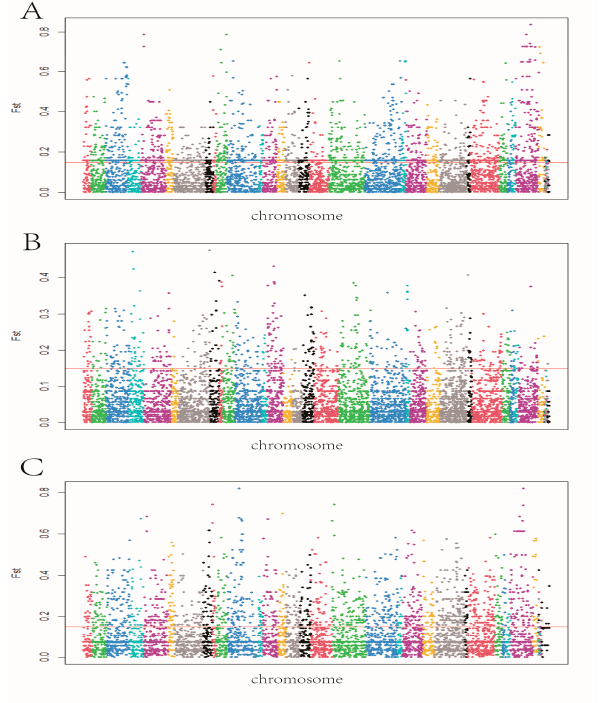
Figure 6. ( A ) Manhattan plots of SNPs in calf compared with adult. ( B ) Manhattan plots of SNPs in adult compared with old. ( C ) Manhattan plots of SNPs in calf compared with old.